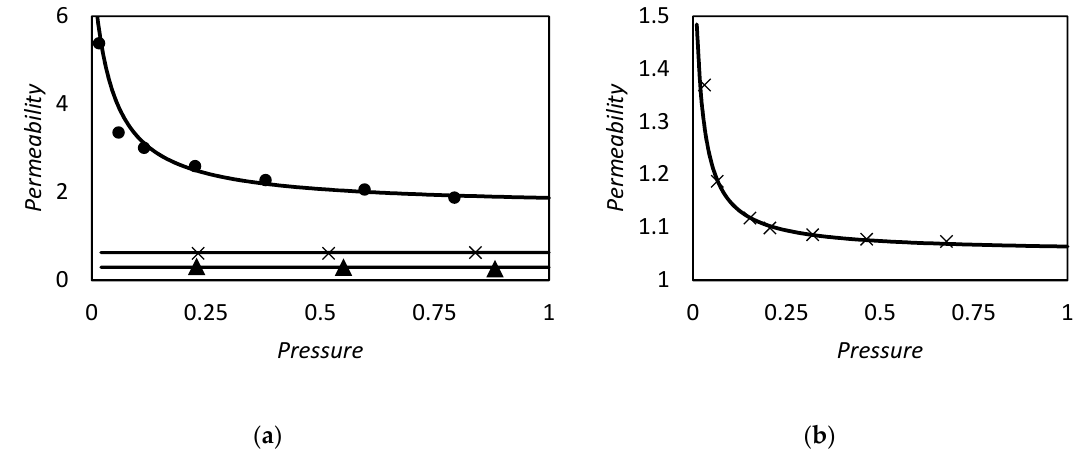
Figure 9. Dual mode model results, permeability as function of upstream pressure. ( a ) Yoshikawa et al. [106]. Circles, crosses and triangles are CO 2 , O 2 and N 2 measured, respectively; ( b ) Nishide et al. [105]. Lines are the model predictions. Permeability is in (1 × 10 − 9 × cm 3 · cm/(cm 2 · s · atm)), pressure is in (atm).